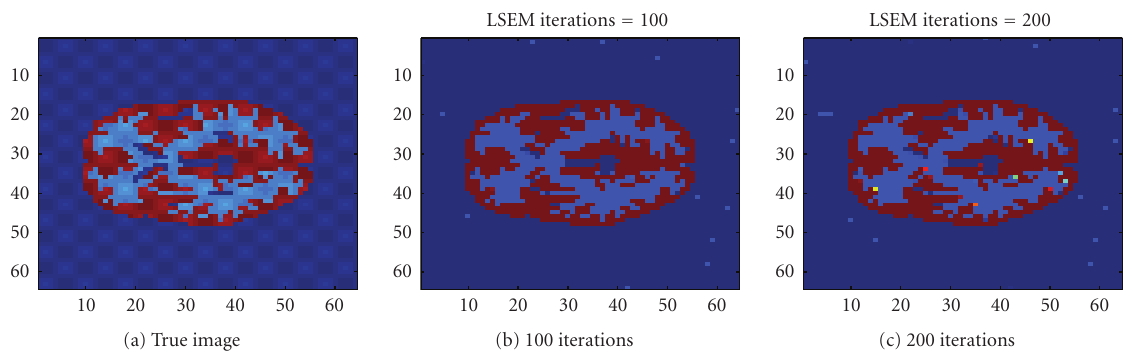
Figure 17: 64 × 64 segmented MRI slice of the brain, nonpiecewise constant by adding sin() functions.